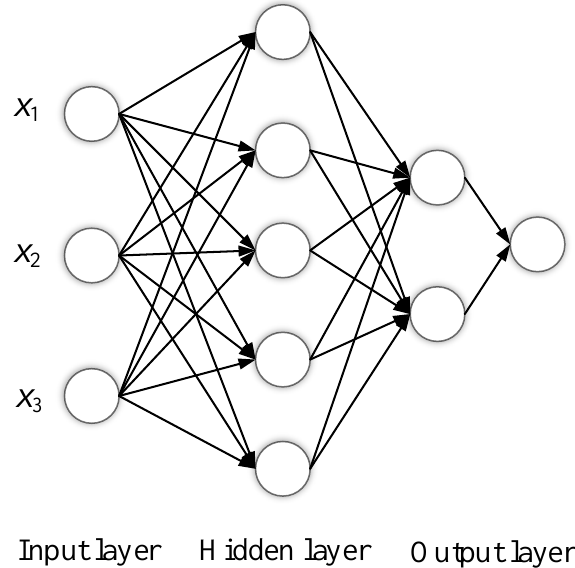
Figure 5. Single-layer extreme learning